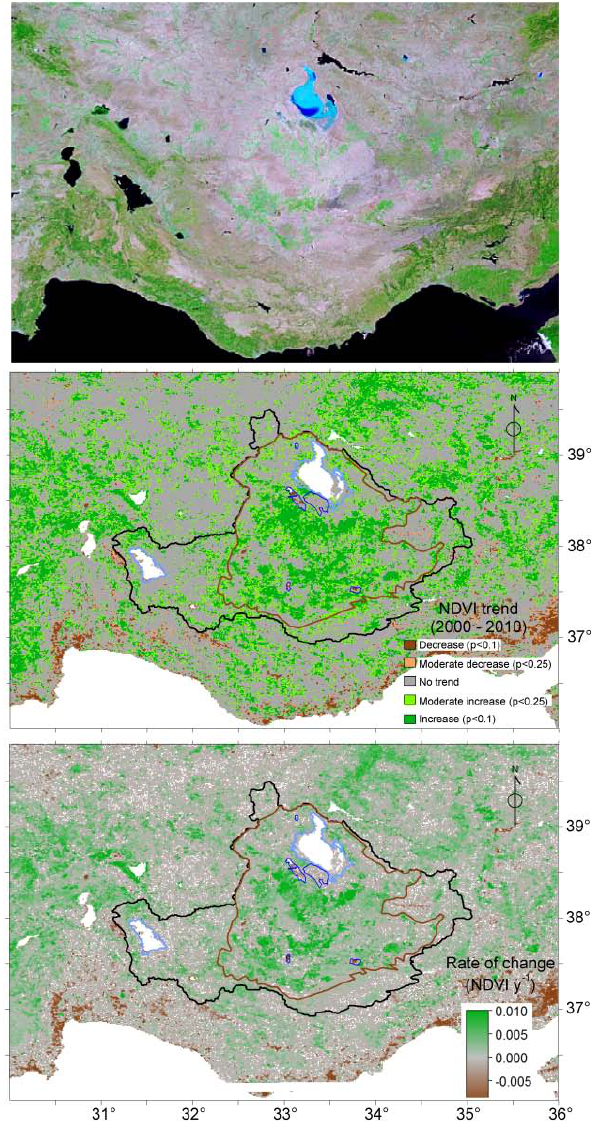
Fig. 8. (a) False-colour composite of MODIS image (RGB = bands 7, 2, and 1), (b) distribution of NDVI trends and, (c) magnitudes of the trends in the yearly average NDVI in and around the Konya Basin.